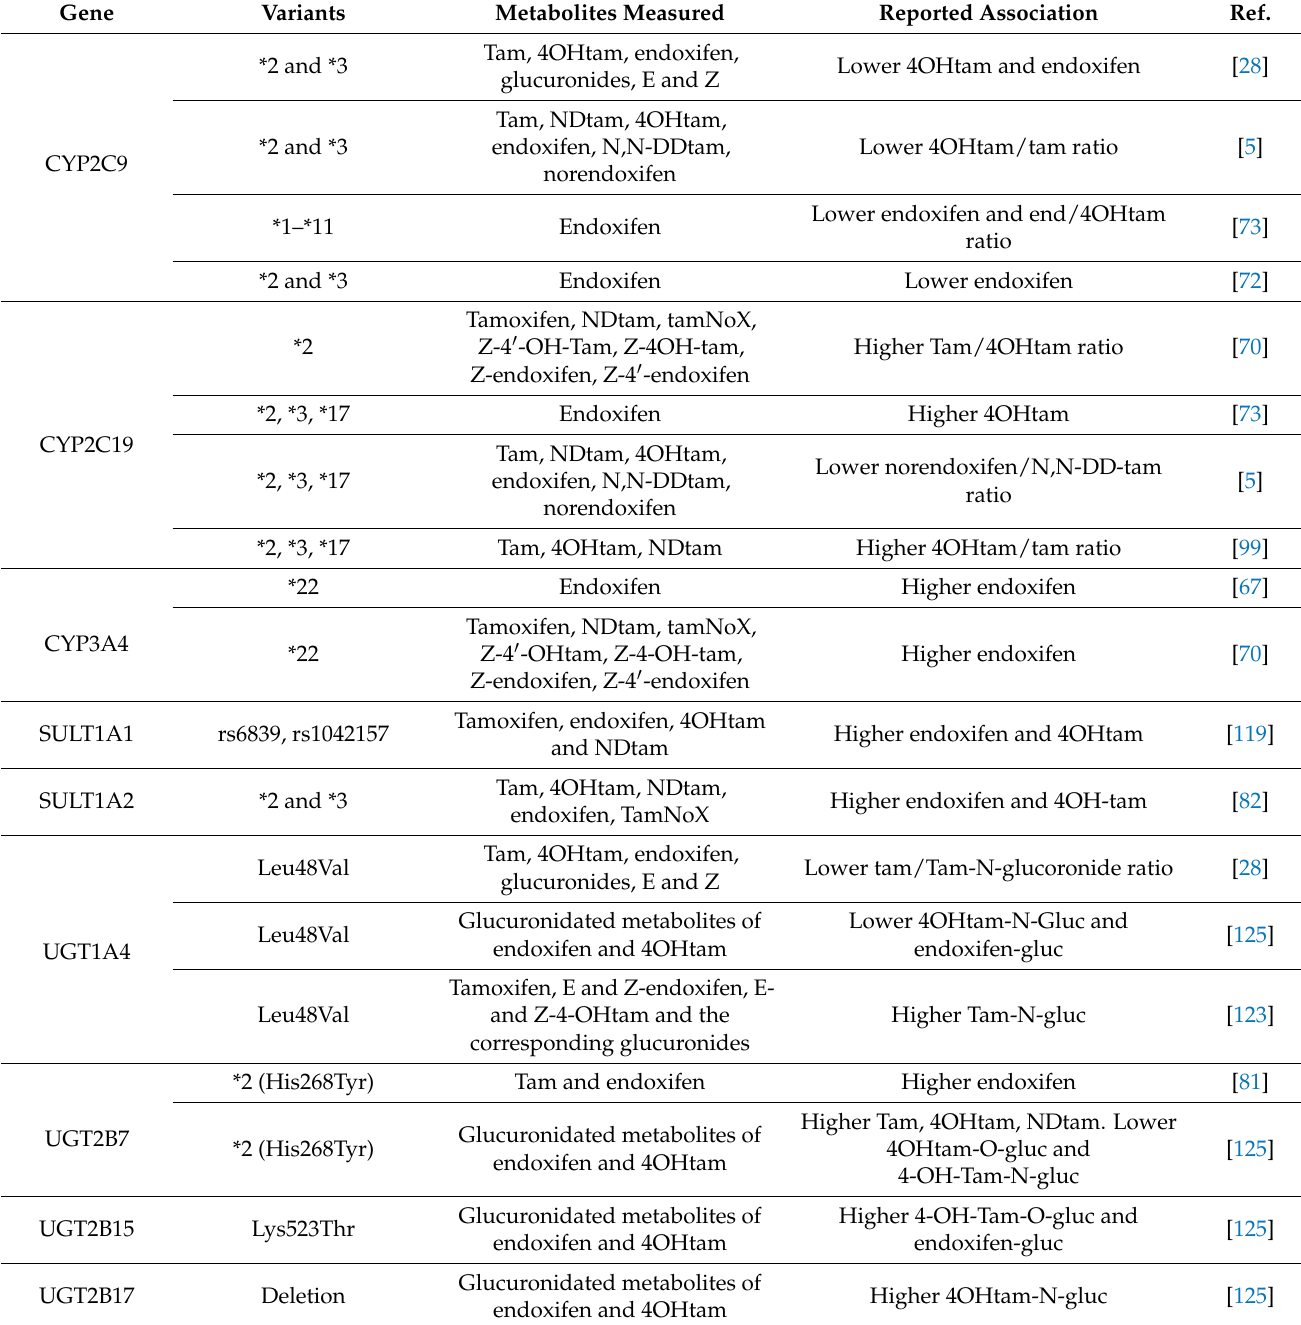
Table 4. Non-CYP2D6 Enzymes associated with tamoxifen, endoxifen, or other metabolites. Gene Variants Metabolites Measured Reported Association